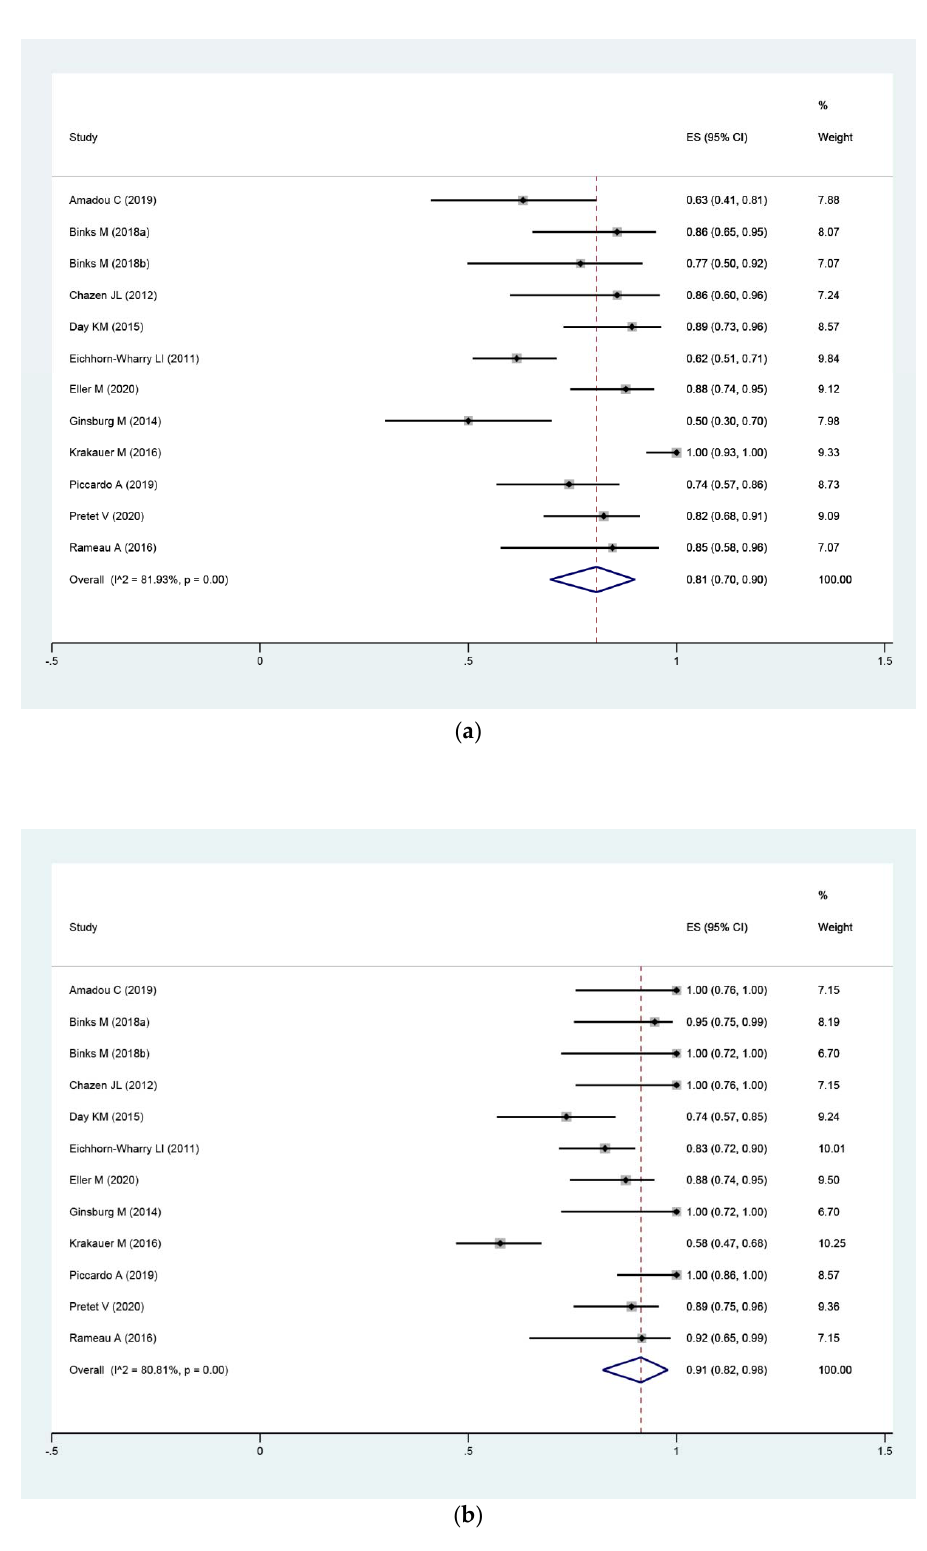
Figure 4. Forest plot of pooled sensitivity ( a ) and positive predictive value (PPV) ( b ) of 4D-CT for localization of HPGs in pHPT patients on a per-patient level, including 0.95 confidence interval